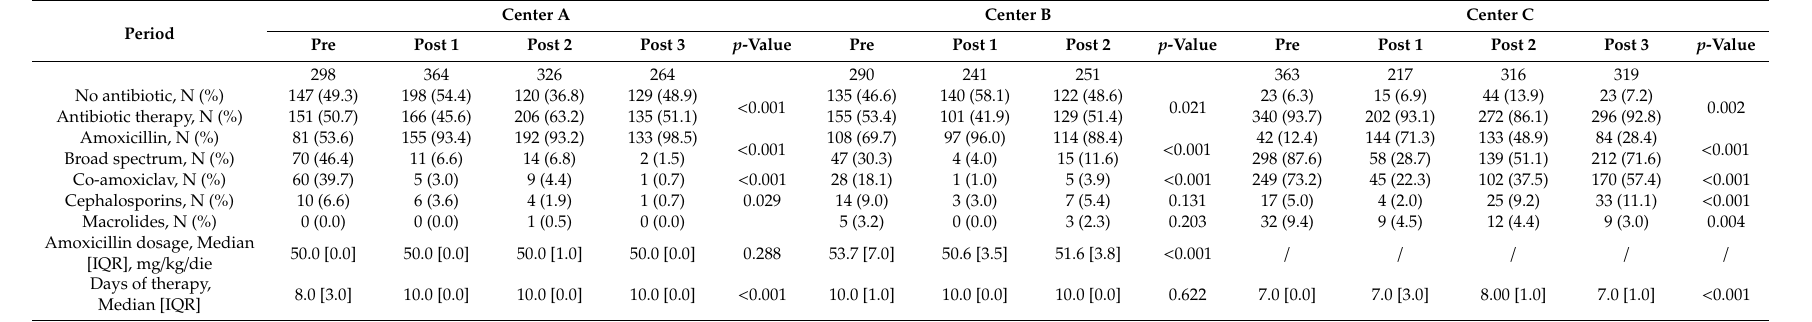
Table 1. Treatment option for pharyngitis in the di ff erent periods in the three